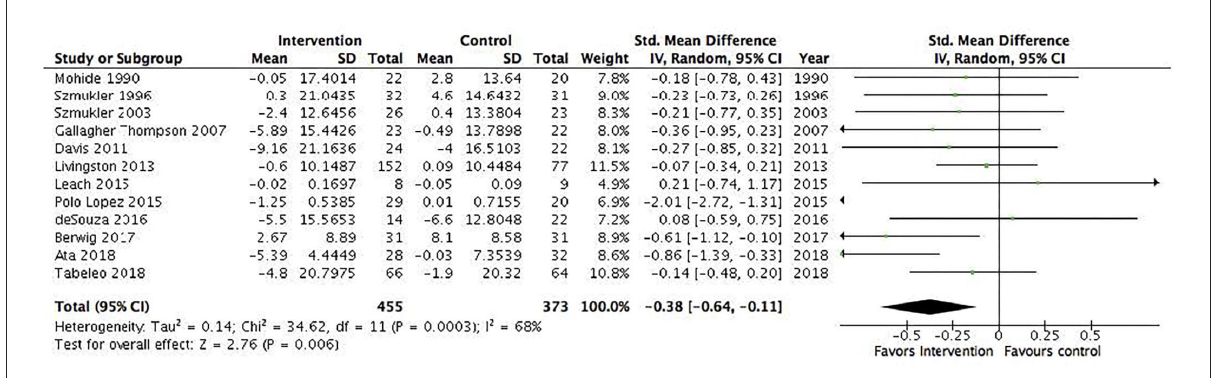
FIGURE6 Subgroup analysis of interventions with an individual delivery format: All studies. Mean within-group changes and standardized mean differences.